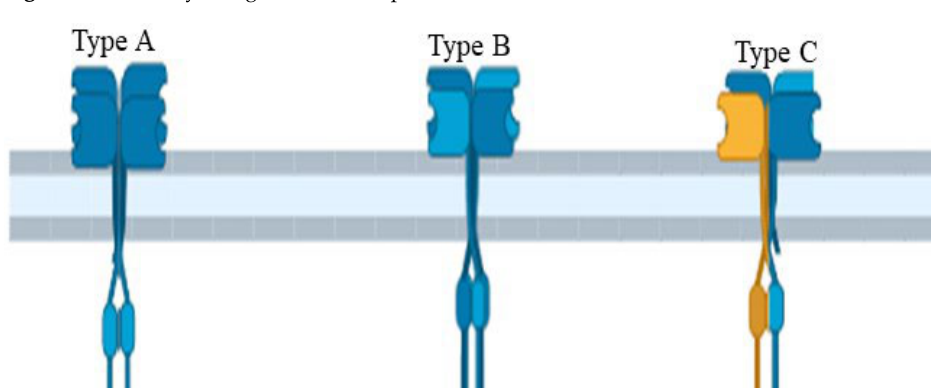
Figure 4. Glutamate receptor channel of Arabidopsis showing the wild type and mutant data of hy- pocotyls.